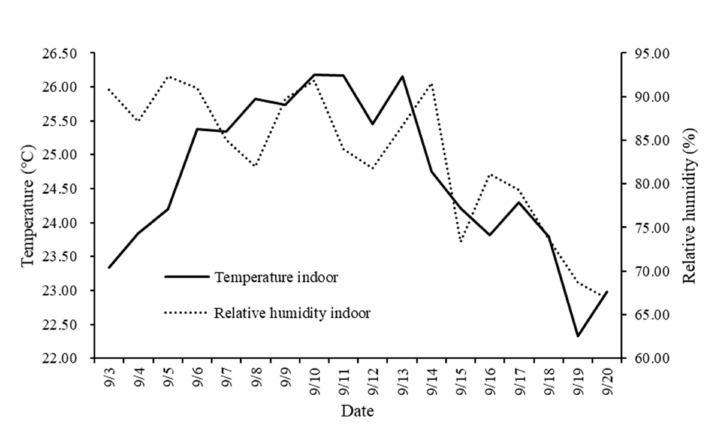
Figure 2. Average daily temperature and relative humidity inside the experimental house.